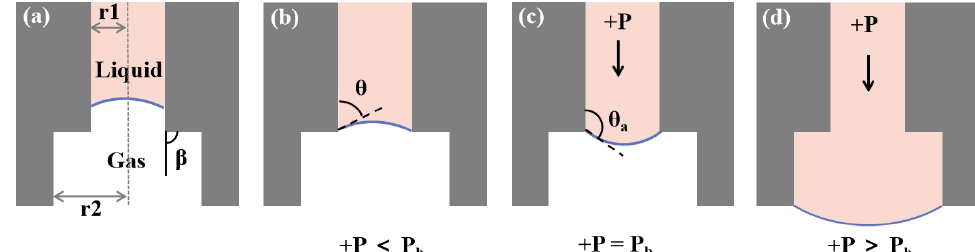
Figure 5. Different situations of liquid flow in capillary valve. ( a ) The internal structure diagram of the capillary valve; the inner radius (r1: 100 µ m, r2: 150 µ m) had two sudden expansions and the channel expansion angle β is 90 ◦ . ( b ) The liquid reached the capillary valve, without external pressure, and the meniscus stopped at the edge of the microchannel outlet. ( c ) The external pressure gradually increased, and the convexity of the meniscus and contact angle became larger. ( d ) When the external pressure exceeded the critical burst pressure, the capillary valve was opened and droplet was transferred to